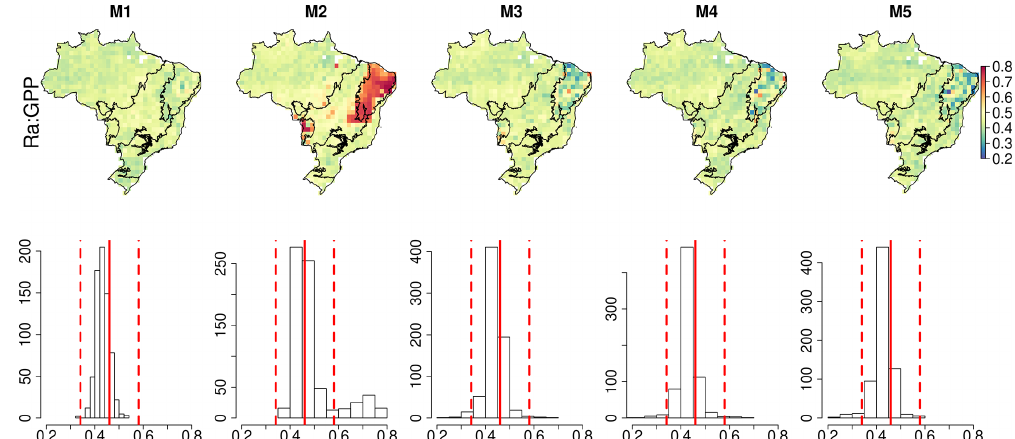
Figure A5. Comparison between R a : GPP estimated by DALEC models and prior value assimilated by CARDAMOM. The top row shows the maps of the pixel-level median estimated by each model. The bottom row shows the histograms of the mapped information. The vertical solid red line shows the prior value and the vertical dashed red line shows the uncertainty range associated with the prior